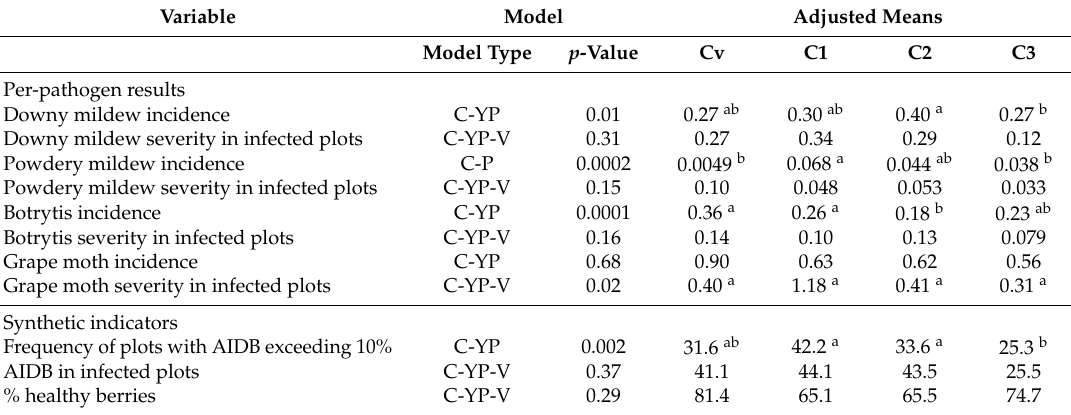
Table 3. E ff ect of the conversion process: model result, significance test, and adjusted means for each studied variable in the vineyard plot network. Model types are described in Section 2.5 (C, Y, and P represent conversion, year, and plot e ff ects, respectively, and V is the variance e ff ects), significance of conversion e ff ect is indicated by the model p -value, and significantly di ff erent adjusted means at 5% threshold are followed by di ff erent